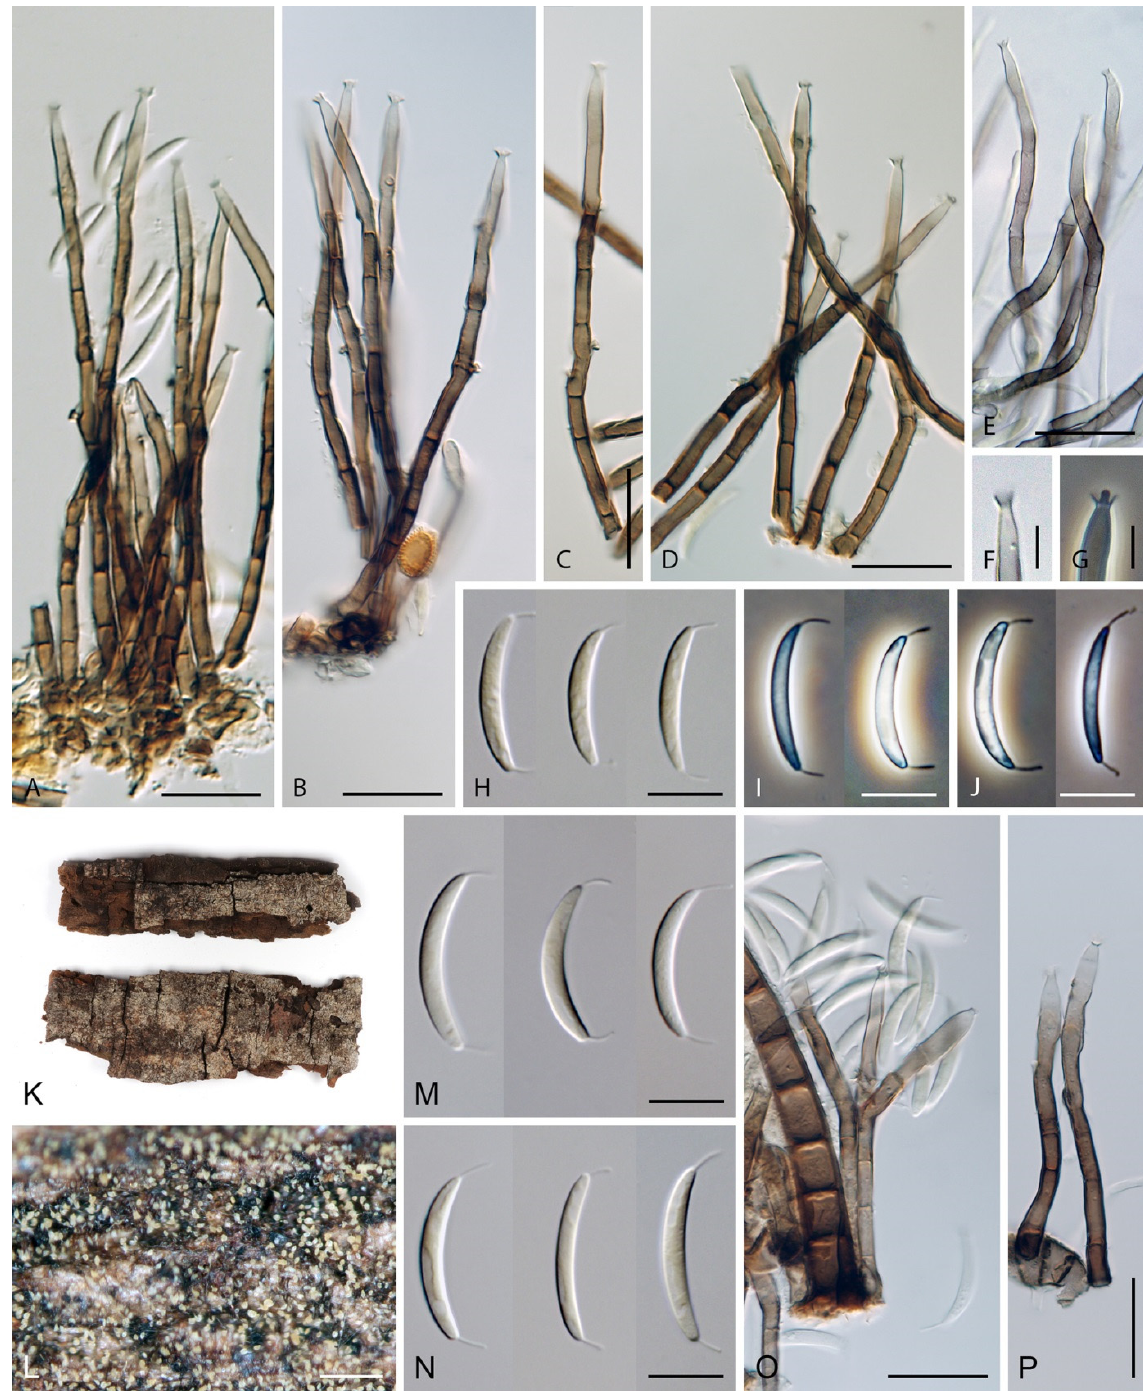
Figure 45. Tainosphaeria vulgaris . ( A – E , O , P ) Conidiophores ( O ) associated with conidiophores of Helicoma sp. ( F , G ) tips of the phialides ( H – J , M , N ) conidia ( K ) substrate with colonies ( L ) colony on wood, in detail. Images: ( A – D , H , I , K – P ) from nature ( E – G , J ) on PCA after 4 weeks; ( A – J ) from PDD 119682 ( K – P ) from DAOM 97315b isotype. Scale bars: ( A – E , O , P ) 20 μ m; ( F , G ) 5 μ m; ( H – J , M , N ) 10 μ m.